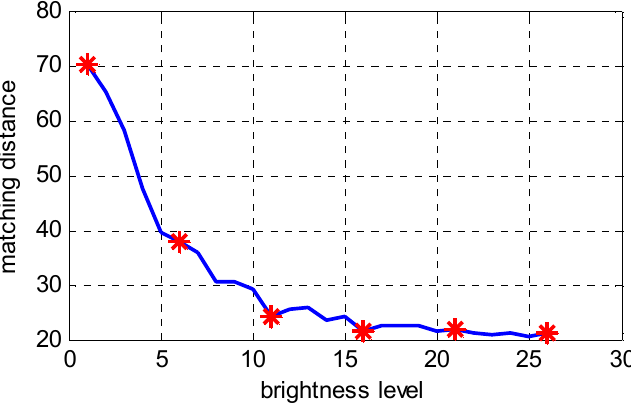
Figure 15. Matching distance for the image sequence in different light intensities.